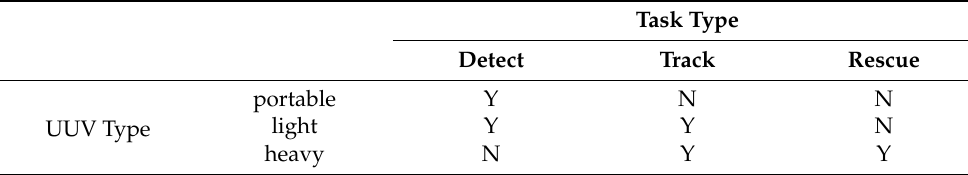
Table 4. UUV and task matching